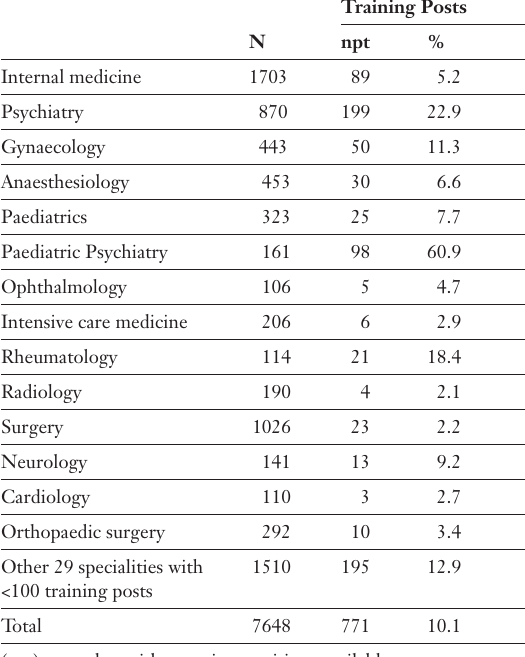
(npt) = number with part-time positions available